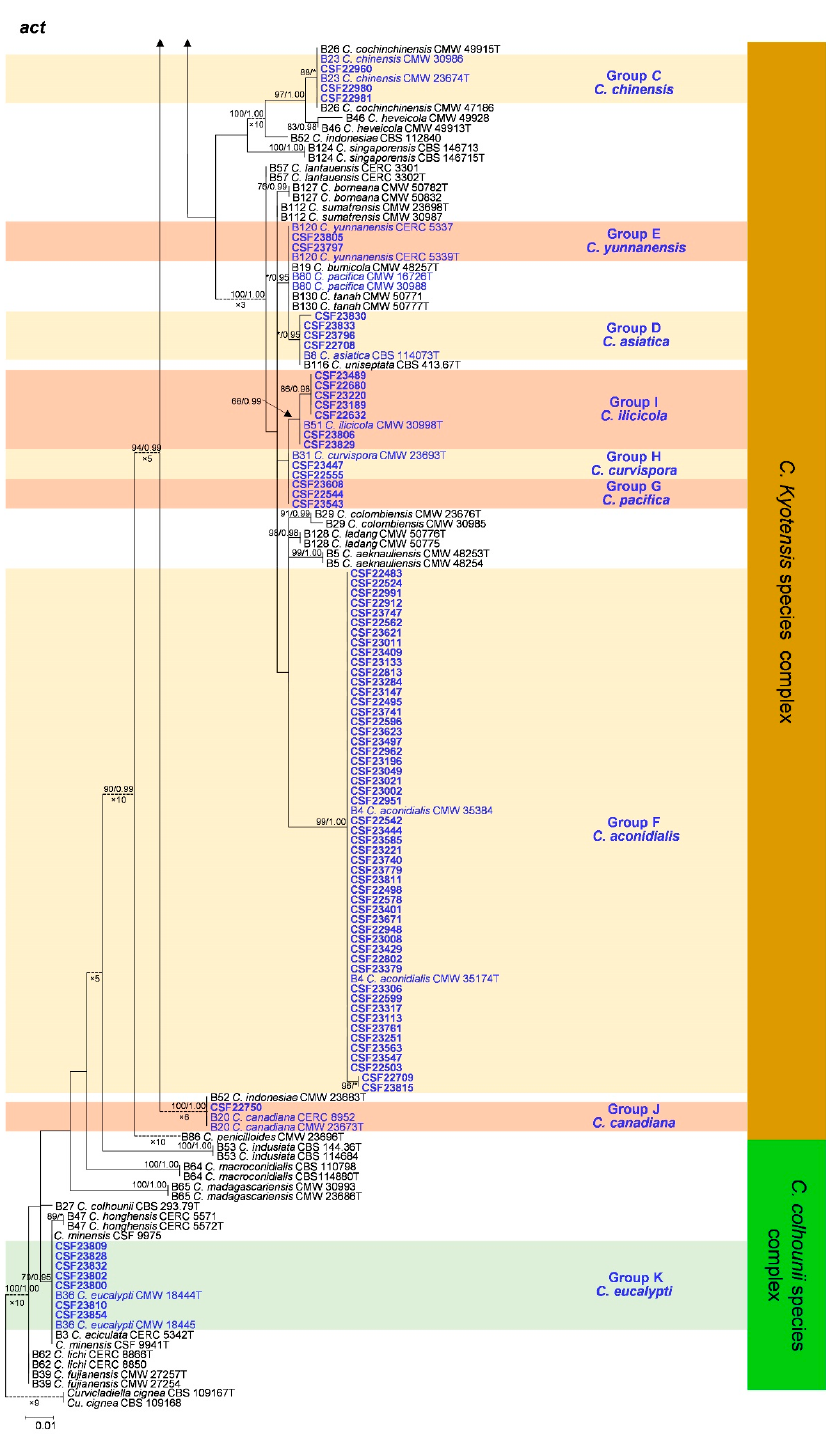
Figure A6. Phylogenetic tree of Calonectria species based on maximum likelihood (ML) analysis of the DNA dataset of the act gene sequences. Bootstrap support values ≥ 70% from ML analyses and posterior probabilities values ≥ 0.95 obtained from Bayesian inference (BI) are indicated at the nodes as ML/BI. Bootstrap values < 70% or posterior probabilities values < 0.95 are marked with “*”, and absent analysis values are marked with “-”. “*/*”, “*/-”, “-/*”, and “-/-” are not displayed. Isolates obtained in this study are highlighted in blue and bold. Ex-type isolates are indicated with “T”. The “B” species codes are consistent with the recently published results of Liu and co-authors [30]. Curvicladiella cignea (CBS 109167 and CBS 109168) was used as the outgroup